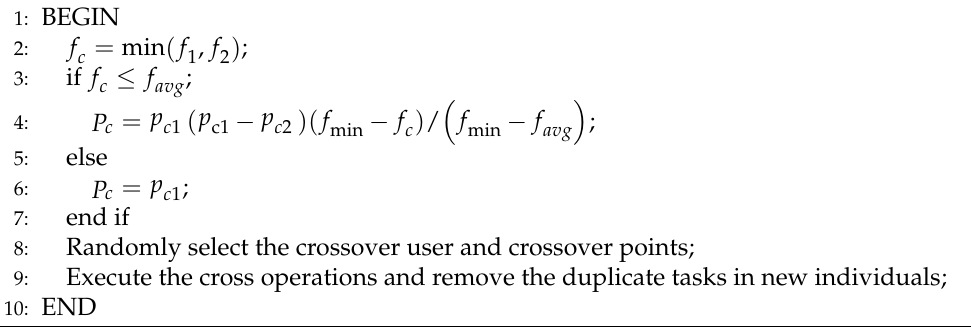
Figure 6. Single − point crossover operation of task offloading position. Algorithm 1 Task execution order single-point crossover